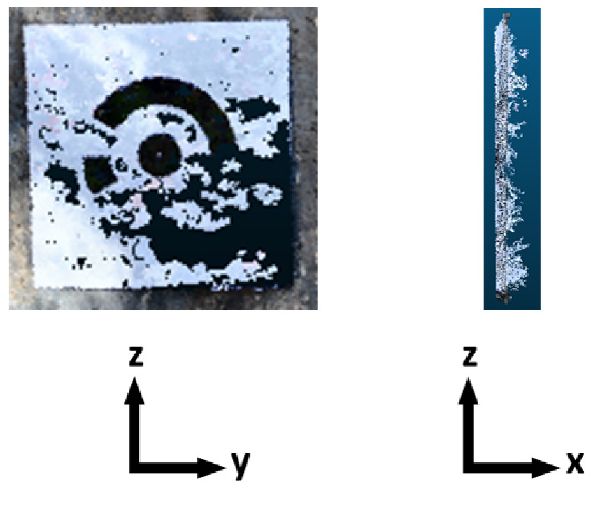
Figure 12. Point cloud data of a registration target.